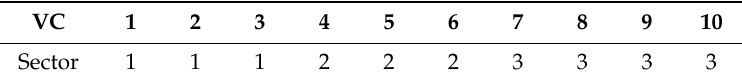
Table 3. Second type of representation of solution x